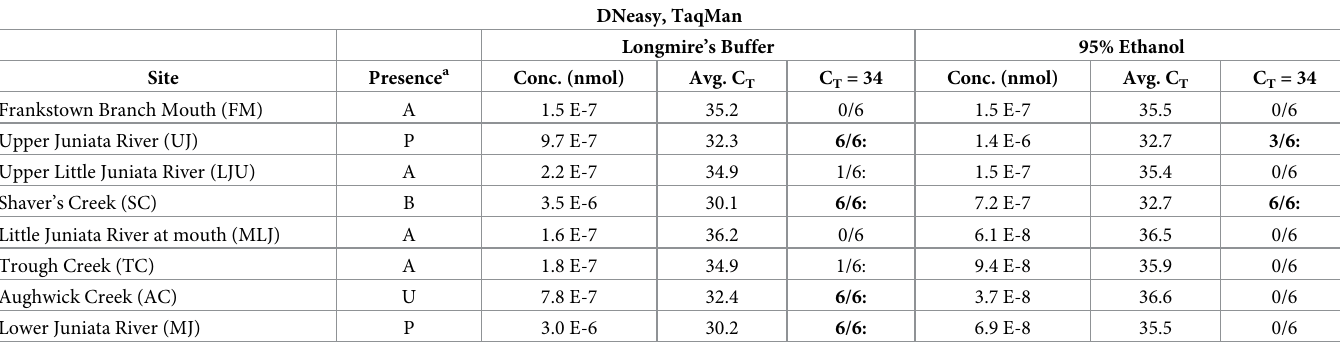
Table 2. Qiagen’s DNeasy Blood and Tissue extraction kit with a TaqMan qPCR assay.